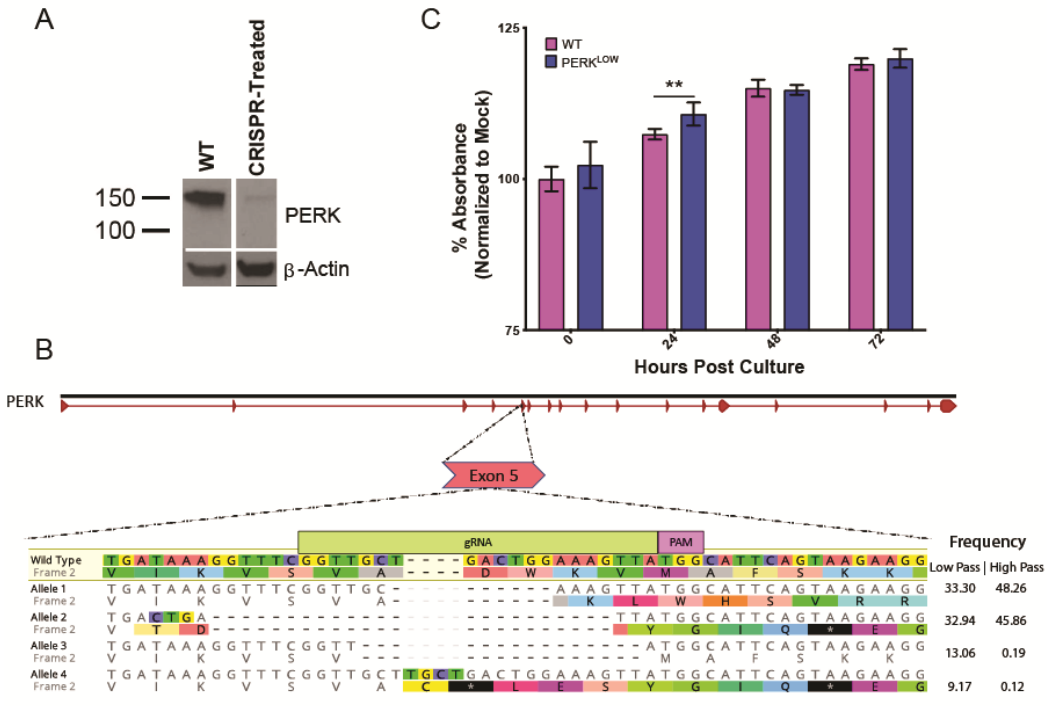
Figure 2. CRISPR-mediated knockdown HEK293T cell line generation. ( A ) HEK293T subclones generated from PERK-specific sgRNA express a gene product at significantly lower abundances. ( B ) Expected editing sites in exon 5 of PERK with sequencing using MiSeq. Four significant alleles were identified, three of which led to early translation termination. All edits occurred as expected in relation to the 20 nt gRNA and PAM-recognition site, denoted in green and purple, respectively. Allelic frequencies are given for both low (p. 13) and high passage (p.108) variants. ( C ) Overall reducing potential of wild-type (WT) and PERK LOW cells was determined over a 72-h time course using an alamarBlue-based protocol. A slight but significant difference (~3%) was observed at 24 h. Statistical significance determined using multiple t -tests and a Holm – Sidak correction. ** p -value < 0.01